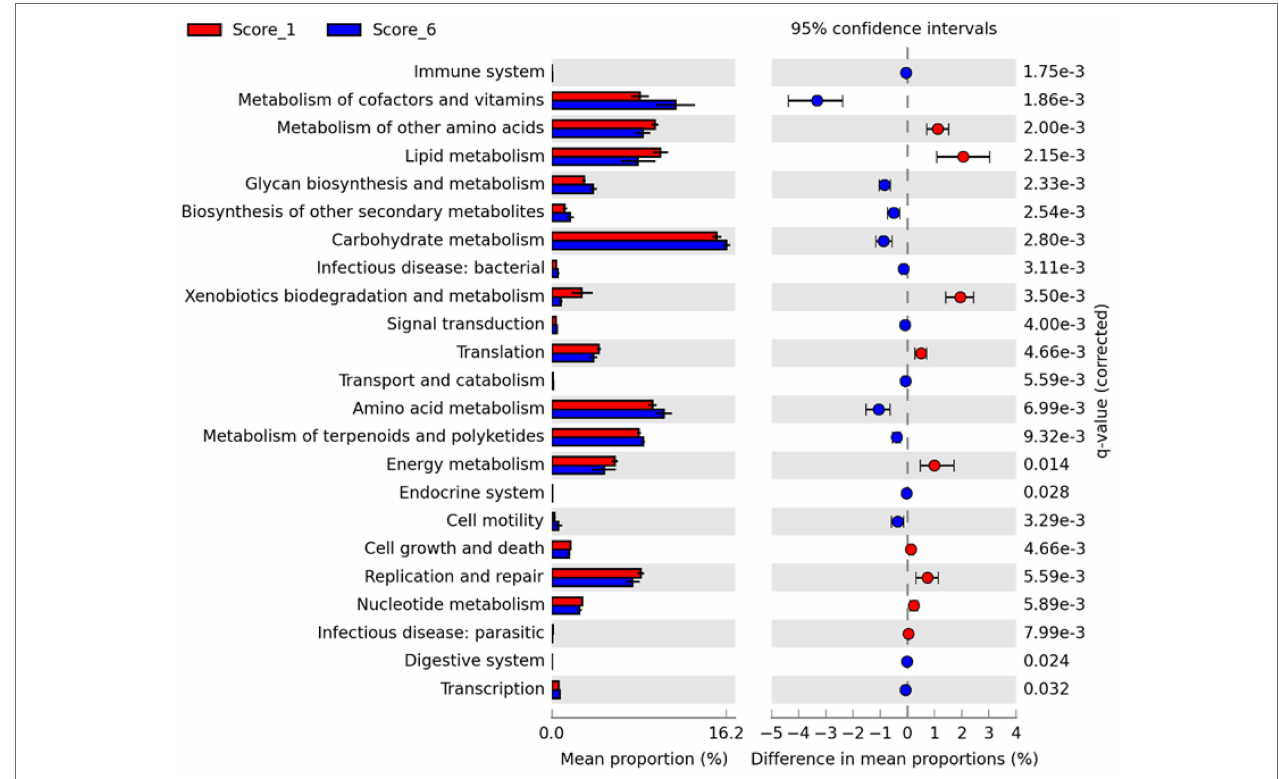
FIGURE 7 | Differential enrichment of predicted KEGG pathways between mild and severe NE. Functional potentials of ileal microbiota of score-1 and score-6 chickens were predicted using PICRUSt2 and level-2 KEGG pathways were compared in Statistical Analysis of Metagenomic Profiles (STAMP). Each bar represents a mean proportion (%) and SEM of a predicted KEGG pathway. The 95% CIs of the differences in mean proportions between score-1 and score-6 chickens were also shown. Significance was determined by two-sided White’s non-parametric t -test, corrected with the Benjamini-Hochberg procedure, and indicated as q values on the right. Only those pathways showing q < 0.05 were